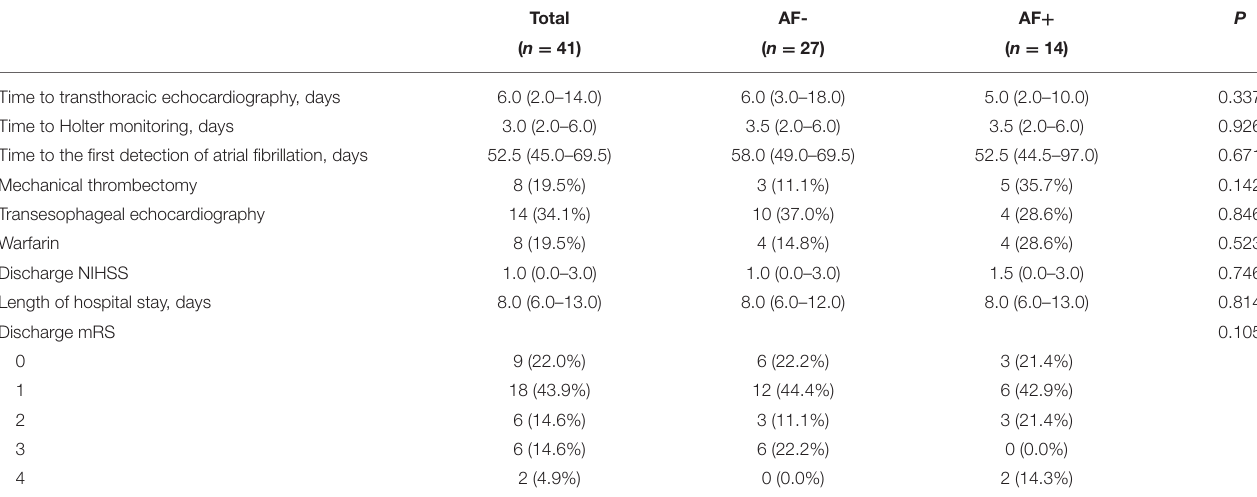
TABLE 3 | Outcomes according to the pattern of